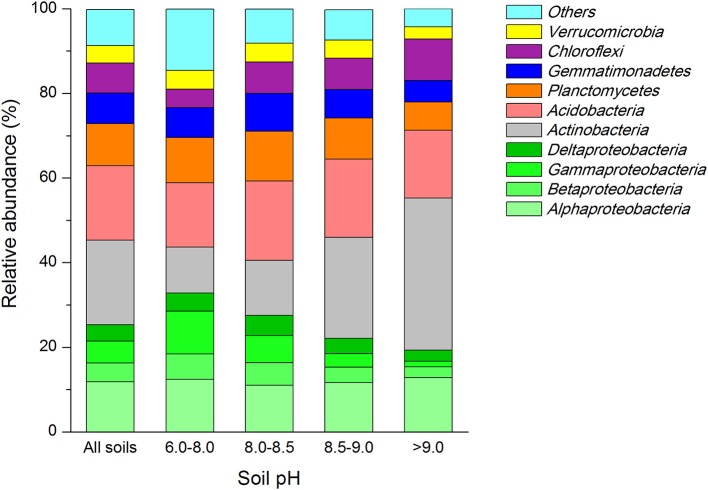
Relative abundances of the dominant bacterial groups across all soil samples and soils grouped into various pH gradients (values represent % of total non-redundant DNA sequences). To indicate their origin on the phylum level, colors were included, green indicate Proteobacteria, Actinobacteria gray, Acidobacteria are red, Planctomycetes are orange, Gemmatimonadetes are blue, purple refer to Chloroflexi, yellow represent Verrucomicrobia.